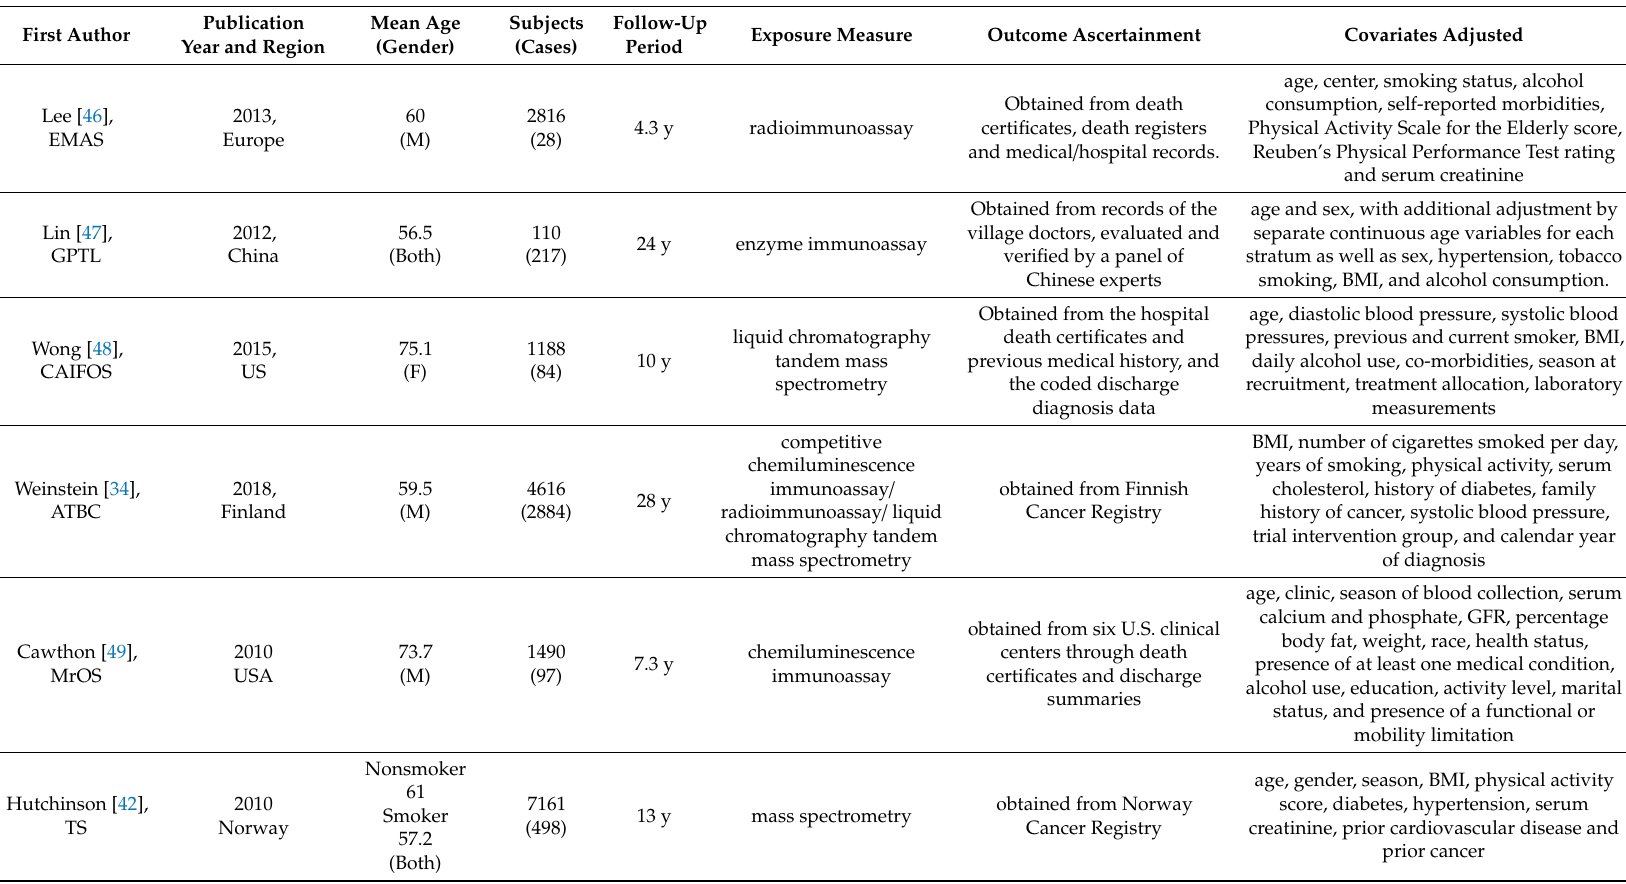
Table 2. Prospective studies reporting on the association of circulating 25(OH)D serum concentration with total cancer mortality